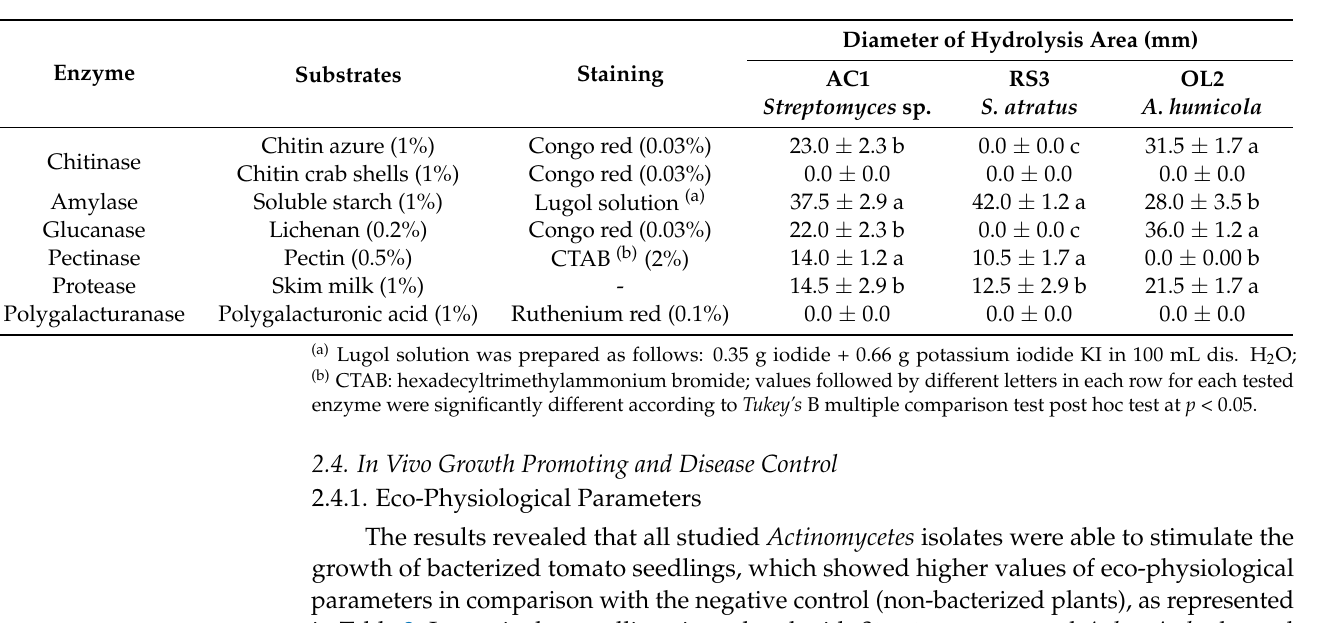
Table 2. Extracellular hydrolytic enzymes produced by the tested Actinomycetes